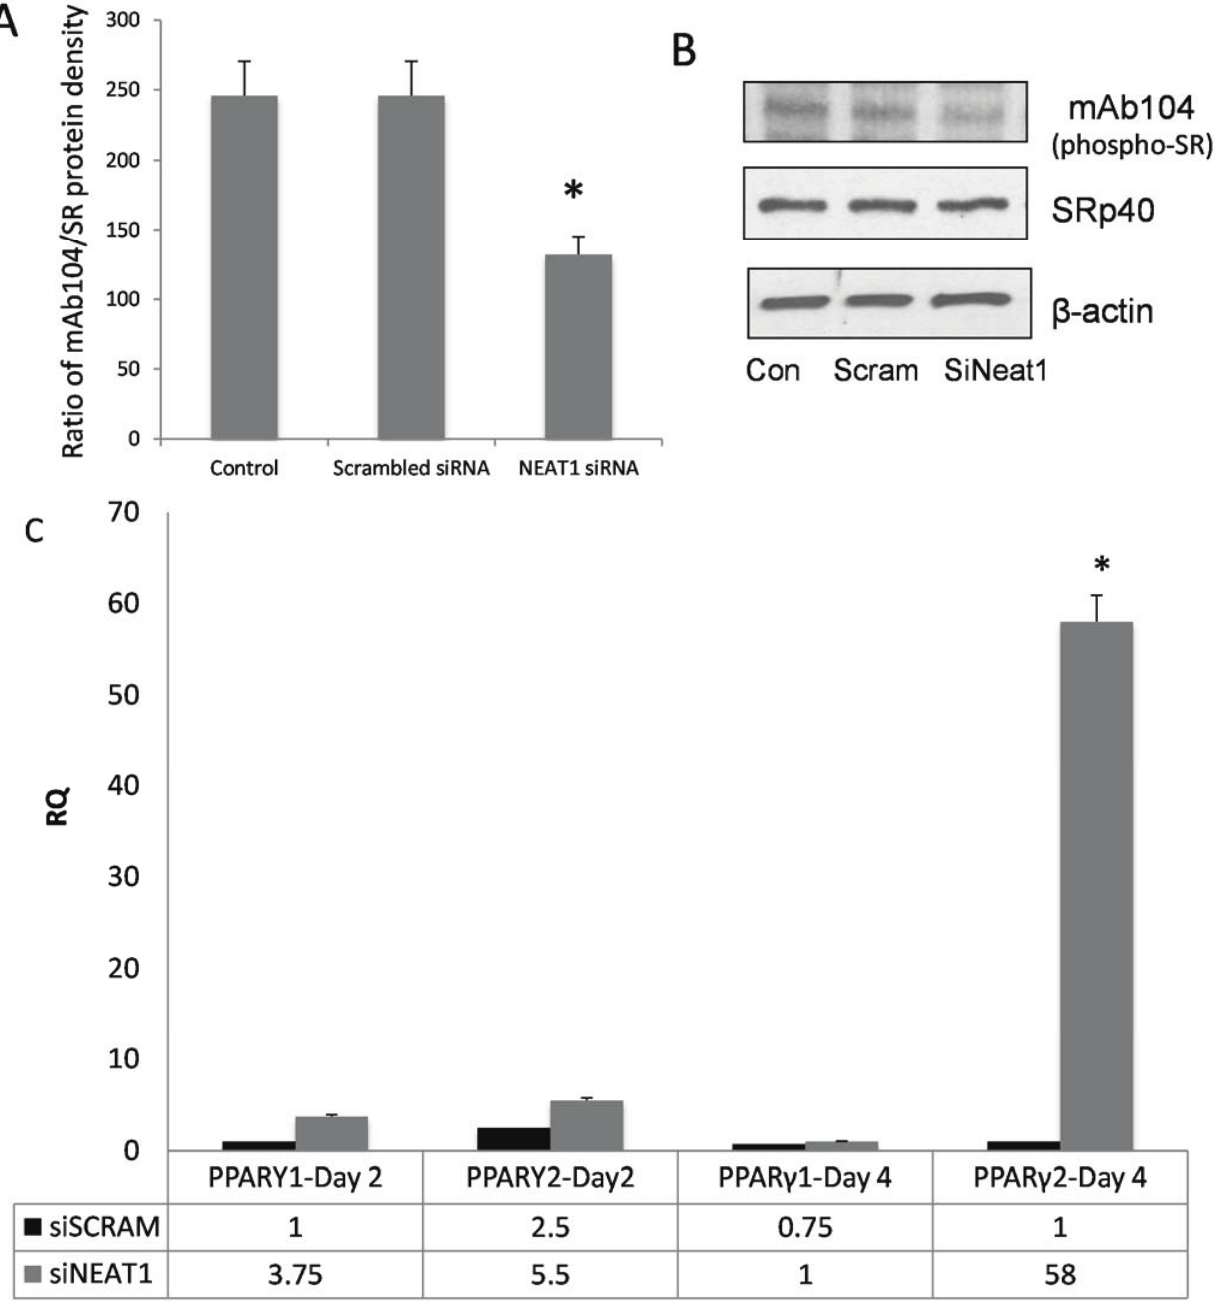
Figure 3. Depletion of NEAT1 decreases phosphorylation of SRp40. 3T3L1 cells were transfected with NEAT1 siRNA (25 nM) and whole cell lysates were collected. ( A ) The ratio of phosphorylated SRp40 vs. SRp40 concentrations are shown after treatment of 3T3-L1 cells with scrambled siRNA or NEAT1 siRNA. Data was analyzed using ANOVA with p > 0.0001 for siNEAT1 treatment; ( B ) Western blots of phosphorylated SRp40, total SRp40 and (cid:3)-actin on day 4 of adipogenesis; ( C ) 3T3L1 cells were transfected with NEAT1 siRNA or scrambled siRNA and analyzed with qRT-PCR for PPAR(cid:2)1 and PPAR(cid:2)2 levels. The experiments were repeated three times with similar results. Day